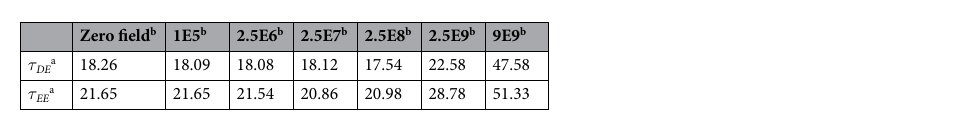
DMSO-ethanol in large field intensity, it is therefore logical that microwave fields boost molecular rotation and provides more opportunities for creating hydrogen bonds between DMSO and ethanol. Intermolecular interaction energy. In order to further interpret the properties changes mentioned above, intermolecular energy of DMSO-ethanol compound, split in their Lennard-Jones and Coulombic contributions, as a function of field intensity is reported in Fig. 7. As can be seen from the diagram, increasing field intensities lead to increase average interaction energy, in absolute value. This behavior of intermolecular energy would justify the lower diffusivities and longer hydrogen bonding lifetimes displayed in Figs 4 and 6. Moreover, from the two quartiles and median lines in boxplot, both instantaneous Lennard-Jones and Coulombic potential energy show strong vibration when the applied field intensities are larger than 2.5 × 10 8 V/m. Nevertheless, the intermolecular energy is almost no change at all for the weak fields, intensities lower than 2.5 × 10 8 V/m, which is accordance with the “critical point” in experiment. Moreover, Fig. 7 also illustrates that microwave energy was redistributed